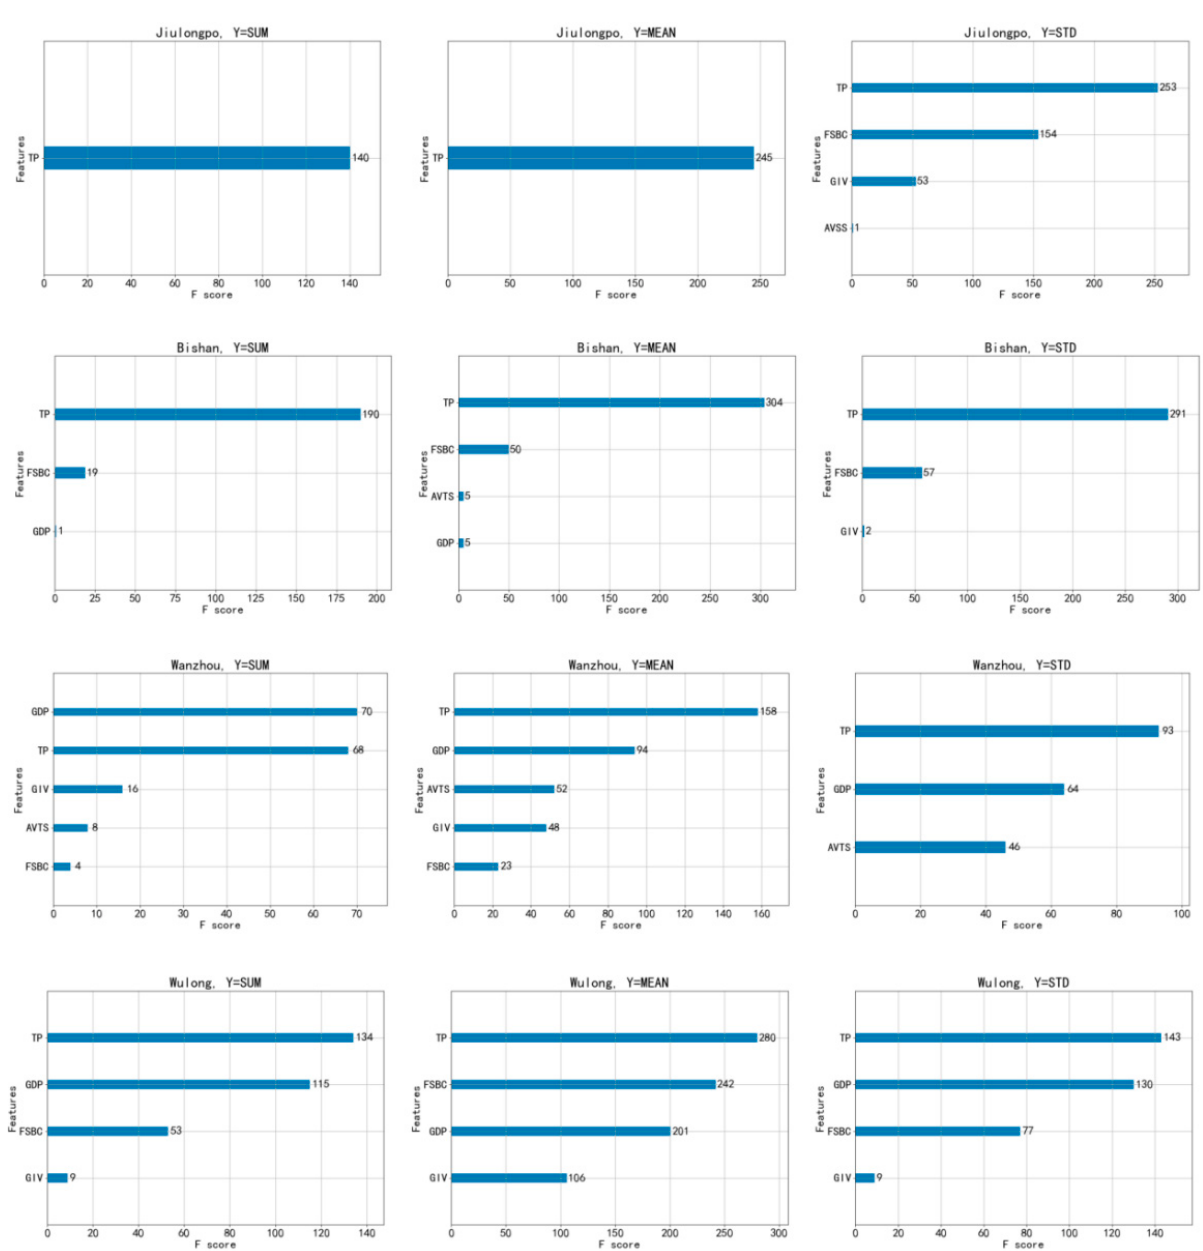
Figure 10. Results of Decision Tree Regression at the suburban district scale.